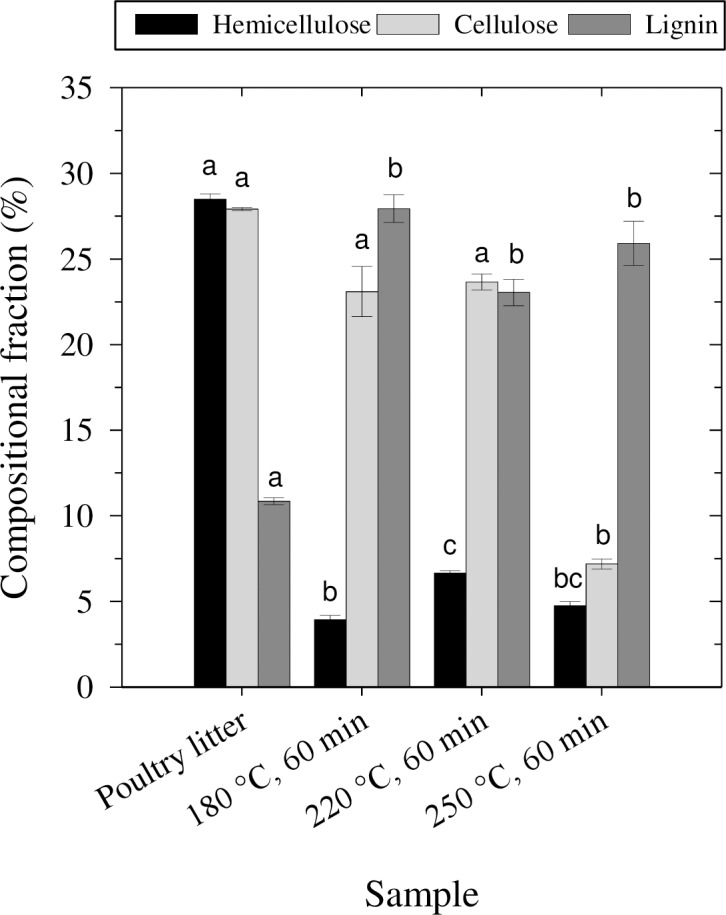
Fiber composition of poultry manure and hydrochar.Data for hydrochar produced at 180°C, 220°C and 250°C after 60 min of treatment is shown. Lowercase letters indicate significant differences between samples for each fiber.